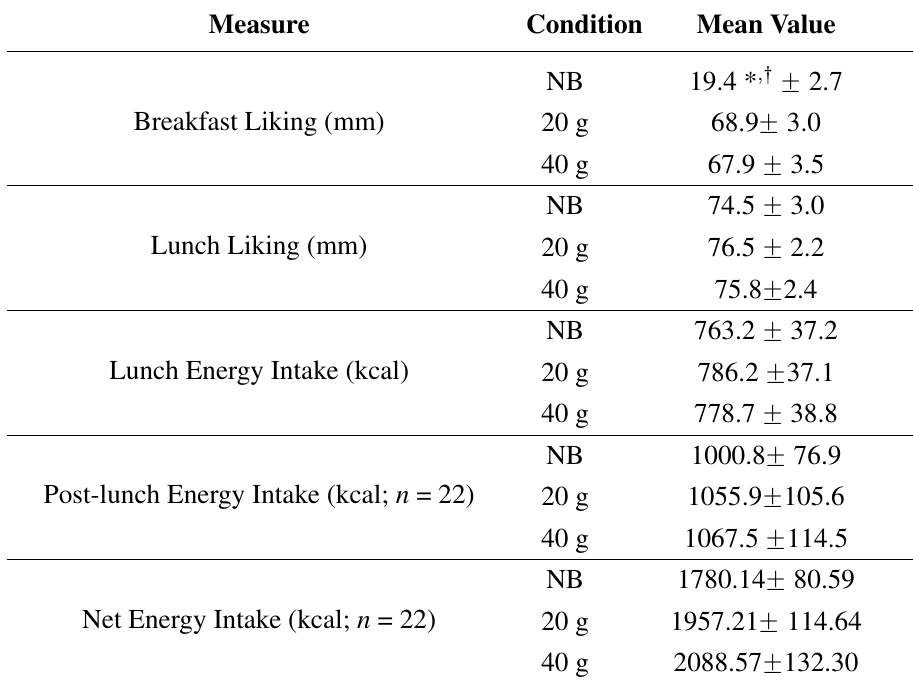
Figure 6. The effects of consuming breakfast cereal (20 g or 40 g) or no breakfast (NB) prior to exercise on hunger, desire to eat, fullness and satisfaction over a 3 h post-exercise period, in habitually active females ( n = 24). Values are time-averaged AUC (* p < 0.05, ** p < 0.01, *** p < 0.001). Table 2. Rate of perceived exertion during exercise, exercise enjoyment, meal liking and energy intake (lunch, post-lunch and net) mean values ( n = 24).